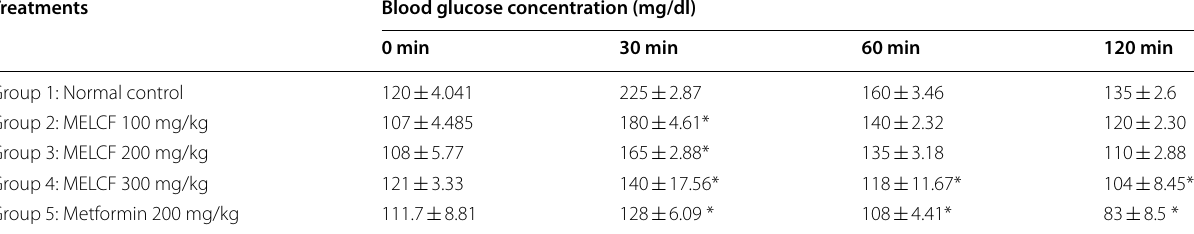
The values represented as mean